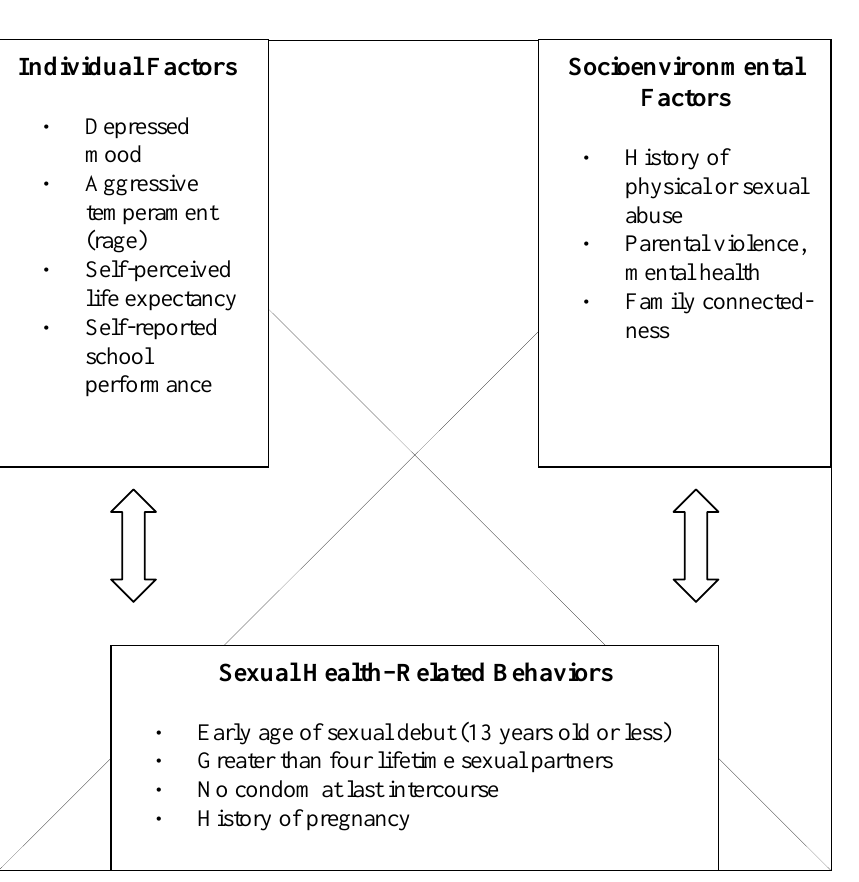
FIGURE 1. Interaction between individual and socioenvironmental factors and sexual health–related behaviors in Caribbean